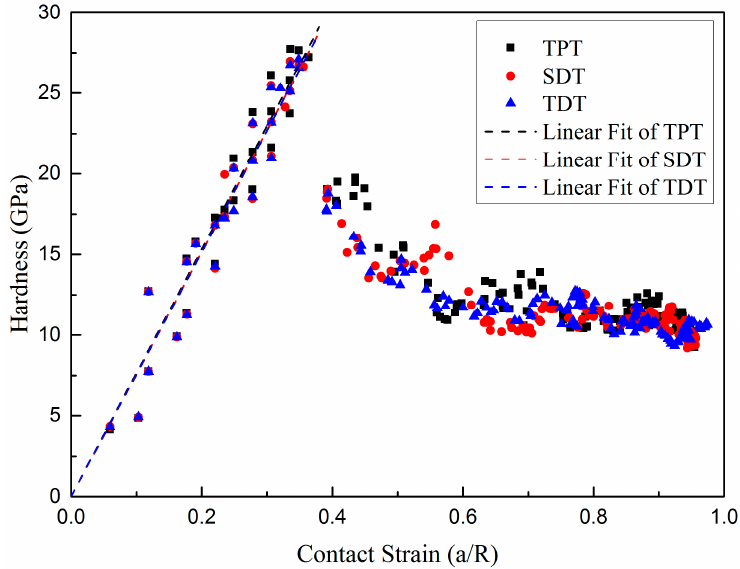
Figure 3. Hardness-contact responses of three different models during nanoindentation, linear fits of three various models during elastic stages.